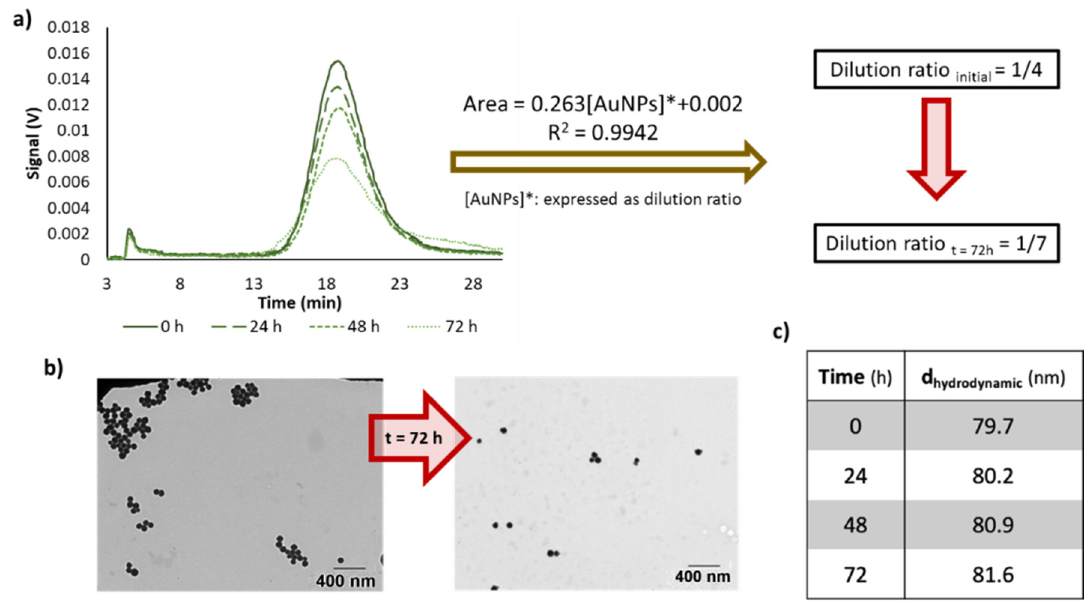
Figure 6. ( a ) Effect in the dilution ratio for AuNPs 60 nm with time. ( b ) TEM micrographs for diluted dispersions of citrate-capped-AuNPs (60 nm) just after their preparation and after 72 h. ( c ) Hydrodynamic diameter of AuNPs at different dilution times (0, 24, 48 and 72 h).